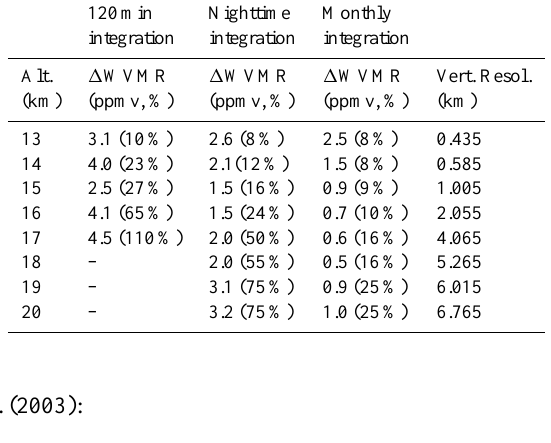
Table 6. Total absolute ( (cid:49) WVMR) and relative errors of the cal- ibrated Raman lidar water vapor measurements in the UTLS (be- tween 13 and 20km) for three different data products: 2h, daily (240min) and monthly